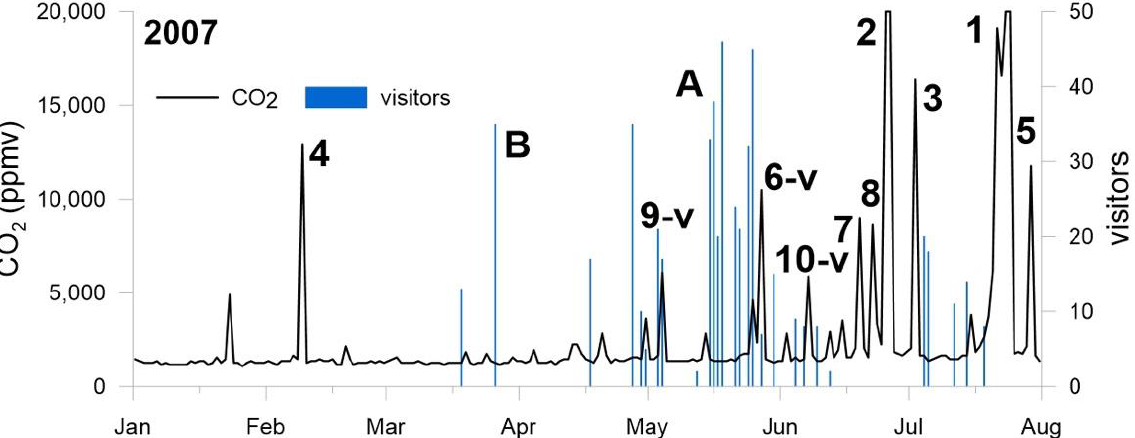
Figure 16. Near-real-time data (daily) of air CO 2 concentration in the atmosphere of the Carburangeli cave (black line), compared to the visitor number (blue vertical bars). Letters indicate the main fruition events not followed by any air CO 2 increase. Numbers indicate the 10 main CO 2 increments, in decreasing amplitude order; the letter “v” highlights those possibly related to fruition events.